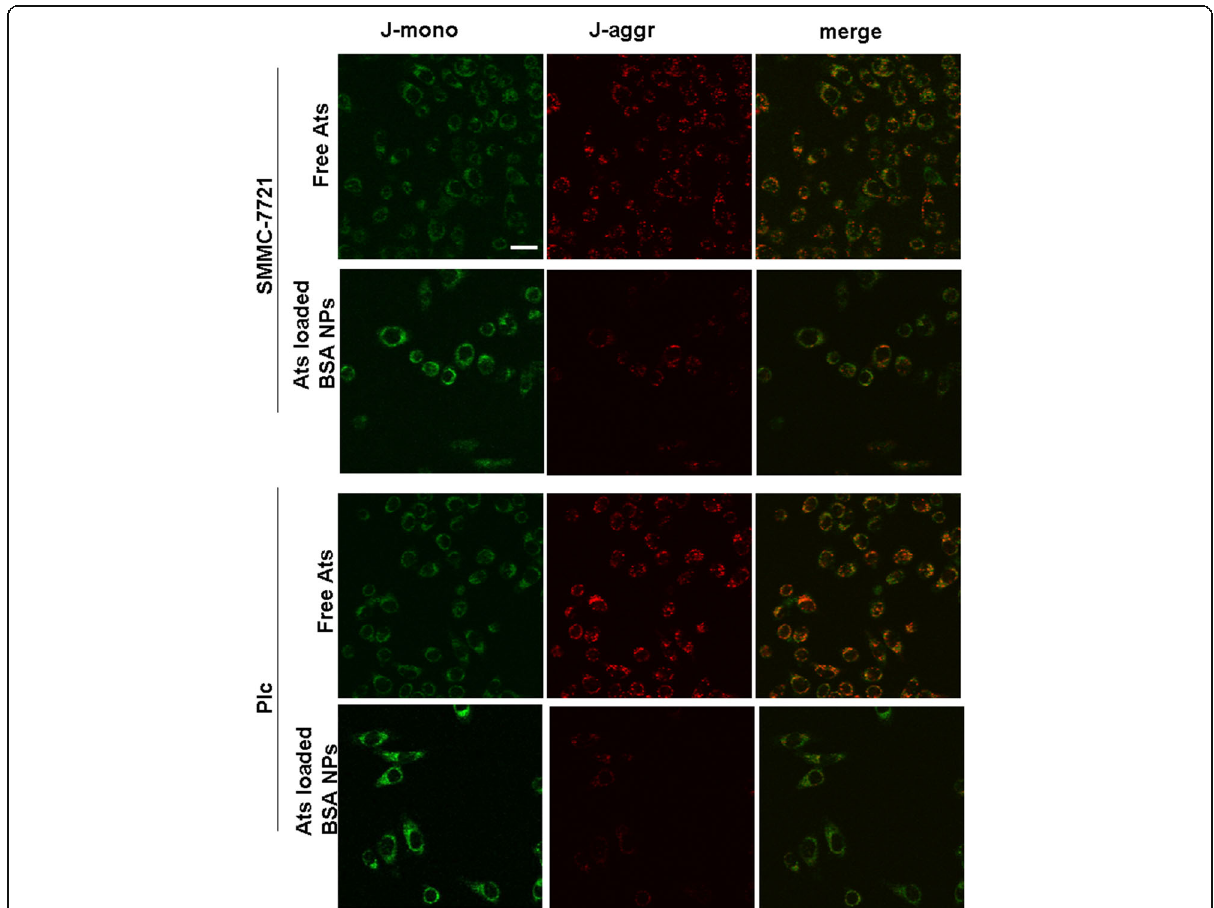
Fig. 3 Imaging change of the mitochondrial membrane potential following incubation of free Ats and Ats-loaded BSA NPs with SMMC-7721 cells and Plc cells. Scale bar , 100 μ